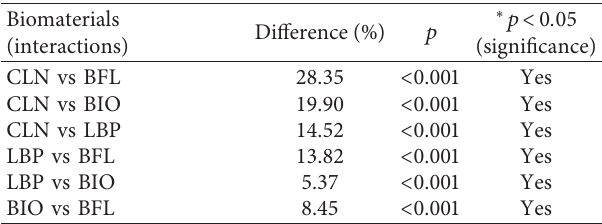
p < 0 . 05 denotes statistical significance.